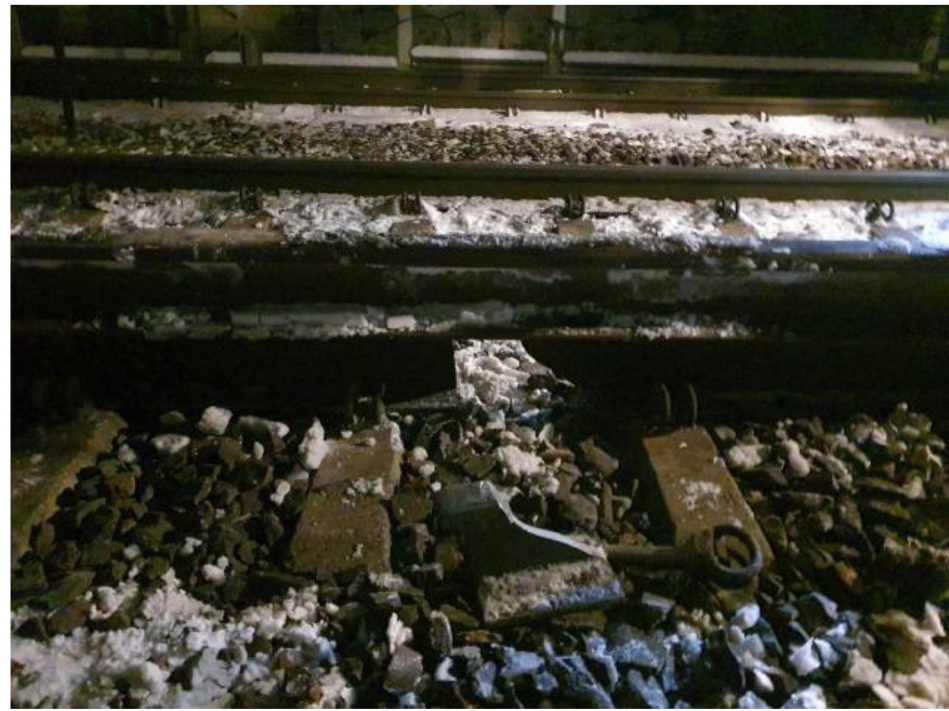
Figure 1. Rail cracking due to low temperatures (source: photo made by Jacek Makowski).